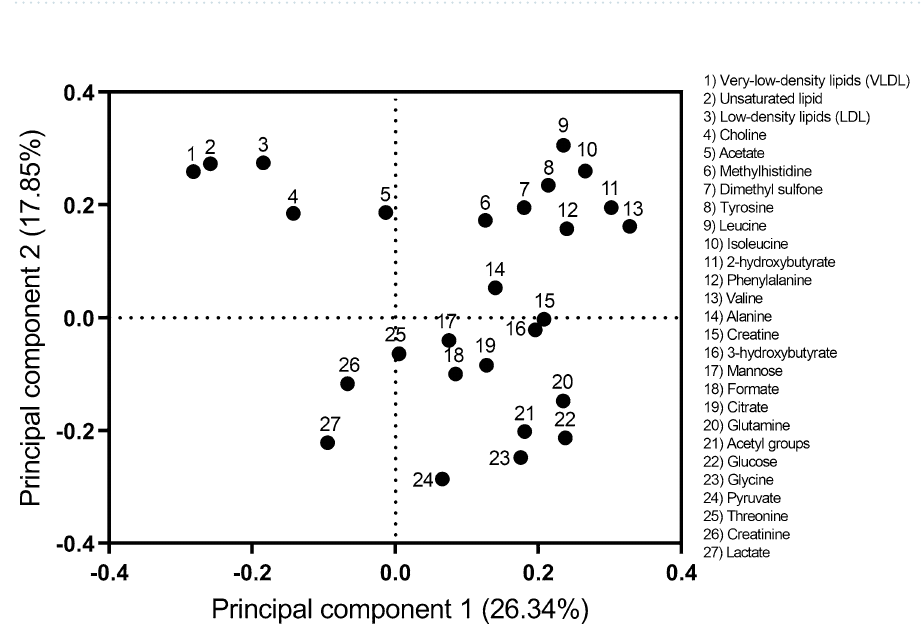
Figure 3. Loading plot from principal component analysis of 27 blood metabolites of grazing beef